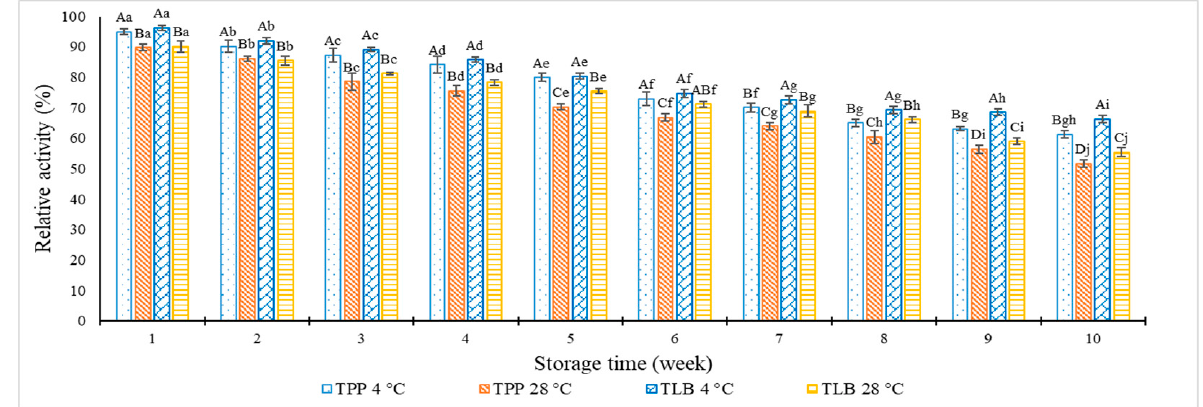
Figure 3. Relative activity of tuna pepsin powder (TPP) and trypsin loaded beads (TLB) in blister pack during 10 weeks of storage at different temperatures (4 °C and 28 °C). Different lowercase letters on the bars within the same storage time denote significant differences ( p < 0.05). Different uppercase letters on the bars within the same storage temperature denote significant differences ( p < 0.05). Error bars represent standard deviation ( n = 3).